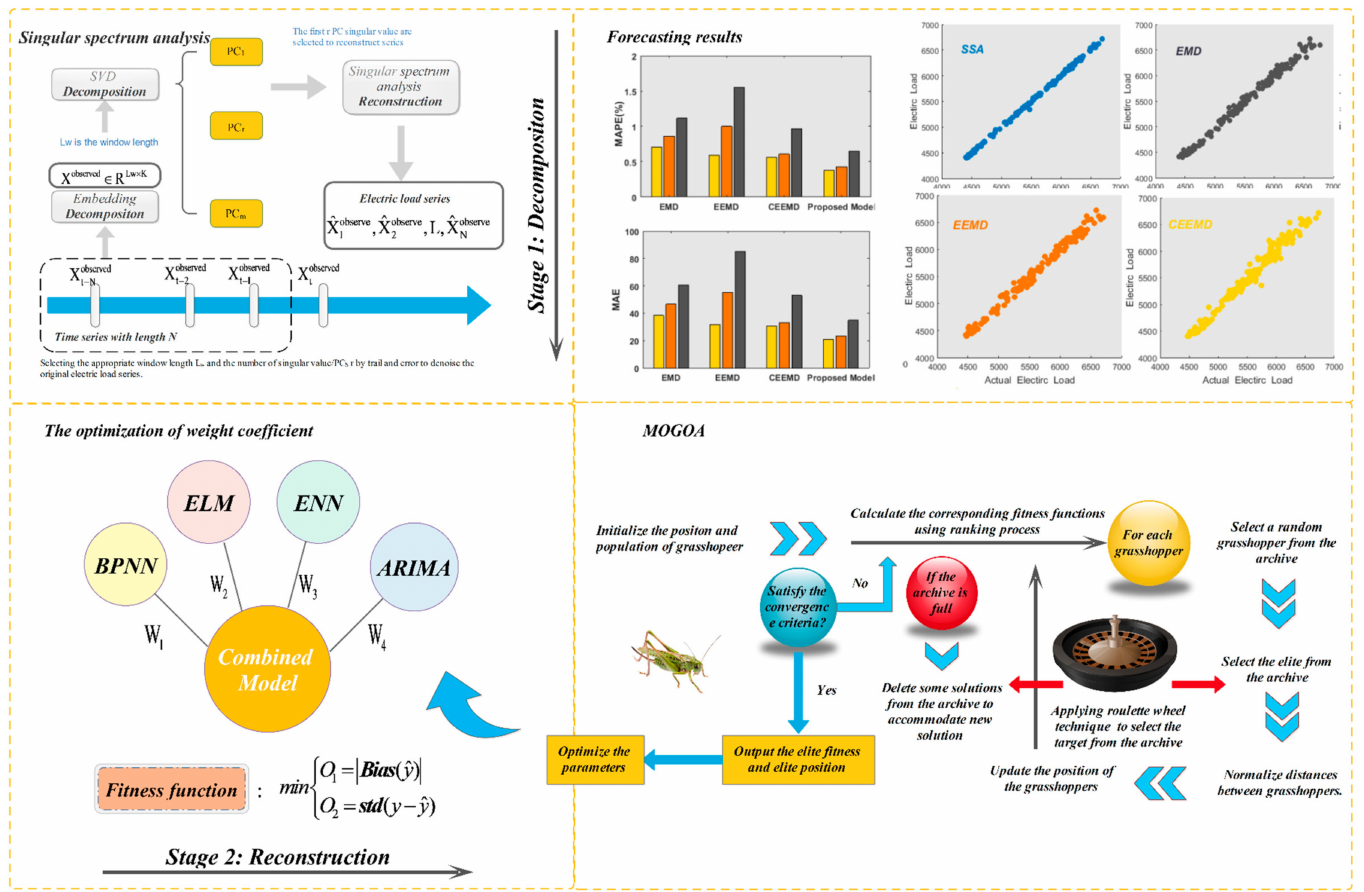
Figure 1. Structure of proposed singular spectrum analysis–multiobjective grasshopper optimization algorithm (SSA-MOGOA) combined